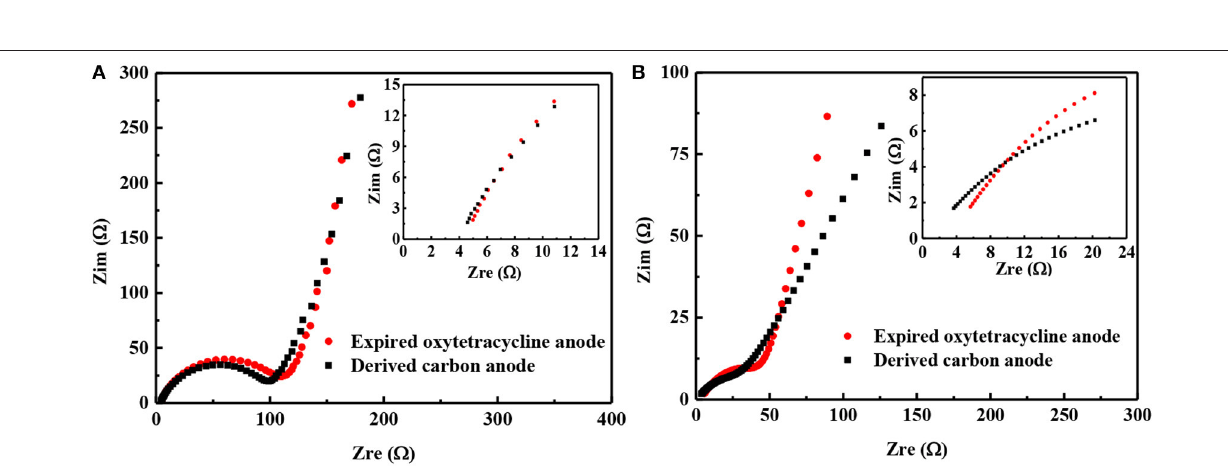
FIGURE 8 | Nyquist plots of two anodes (A) before and (B) after 500 cycles.